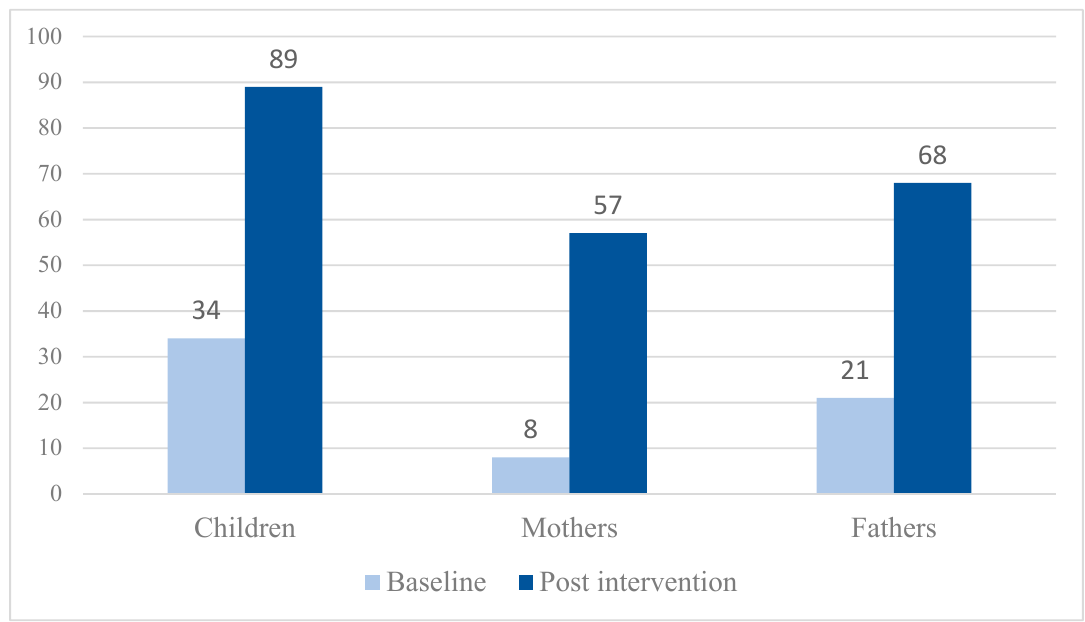
Figure 1. Percentage of children, mothers and fathers meeting Australia’s physical activity guidelines at baseline versus post intervention.